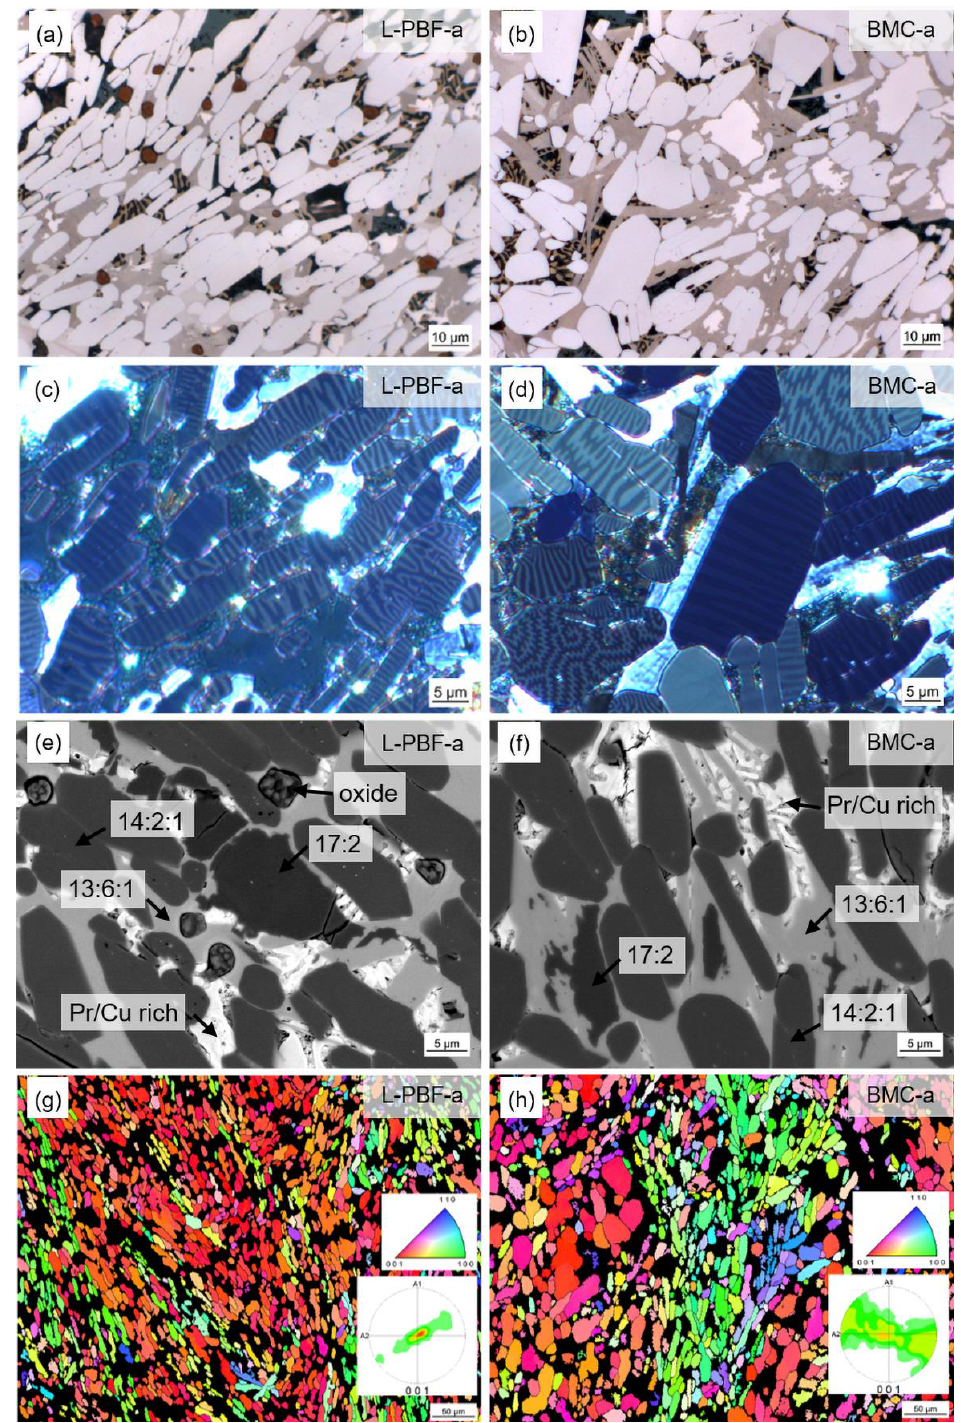
Figure 6. Microstructure of 3D-printed (L-PBF) and annealed Fe73.8-Pr20.5-Cu2.0-B3.7 observed for polished microsections in the as-built state ( L-PBF-a ) (left) in comparison with BMC material of the same composition ( BMC-a ) (right): ( a , b ) Optical microscopy image. ( c , d ) Kerr microscopy image. ( e , f ) SEM image (backscatter electron detector). ( g , h ) EBSD analysis (inverse pole figure IPF). L-PBF-a and BMC-a show the same phase composition and morphology. Original grain orientation patterns are preserved during heat treatment; however, the typical textures of both samples are more pronounced. Microsections were made in the z–y plane (same definition of axes in Figure 4).